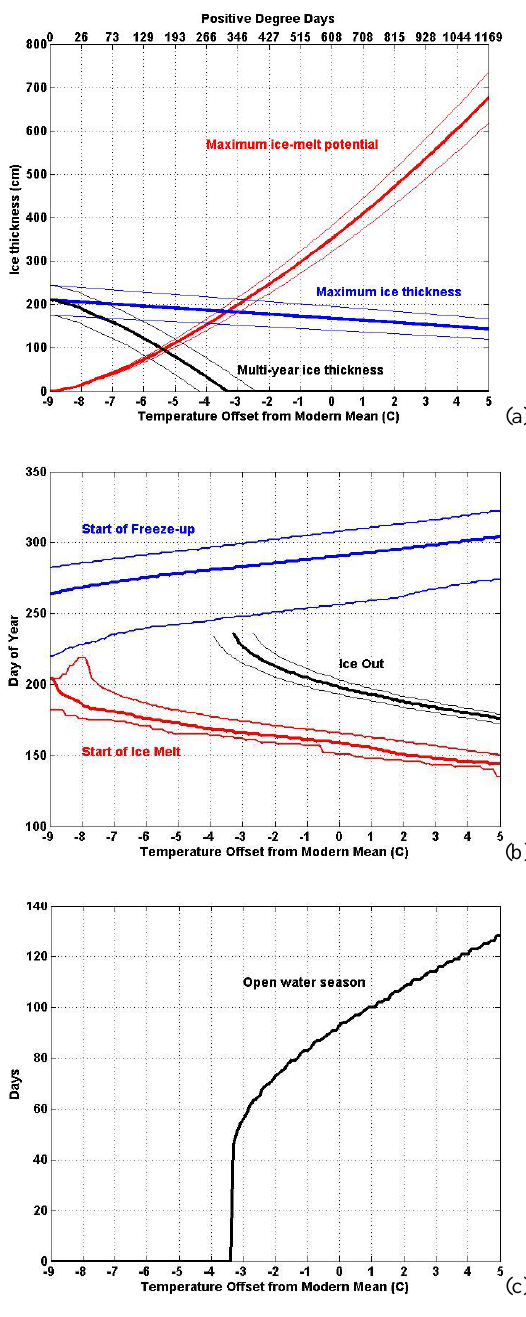
Fig. 7. Model output for shifting the mean NNR air temperature uniformly from − 9 to + 5 ◦ C. In (a) , maximum ice melt potential, ice thickness, and multiyear ice thickness are shown (thick lines) with parameter uncertainties (thin lines) as described in the text. After a 3.5 ◦ cooling, ice does not completely melt before freeze-up begins. In terms of creating anoxic conditions, likely another 1– 2 ◦ C cooling is required to leave ice thick enough to prevent water– atmosphere oxygen exchange. In (b) , dates of initial freeze-up, ice melt, and ice-out are shown (thick lines) with parameter uncertain- ties (thin lines) as described in the text. In (c) , the model open water season length in shown, with the value rapidly dropping off towards zero after 3 ◦ C cooling compared to modern